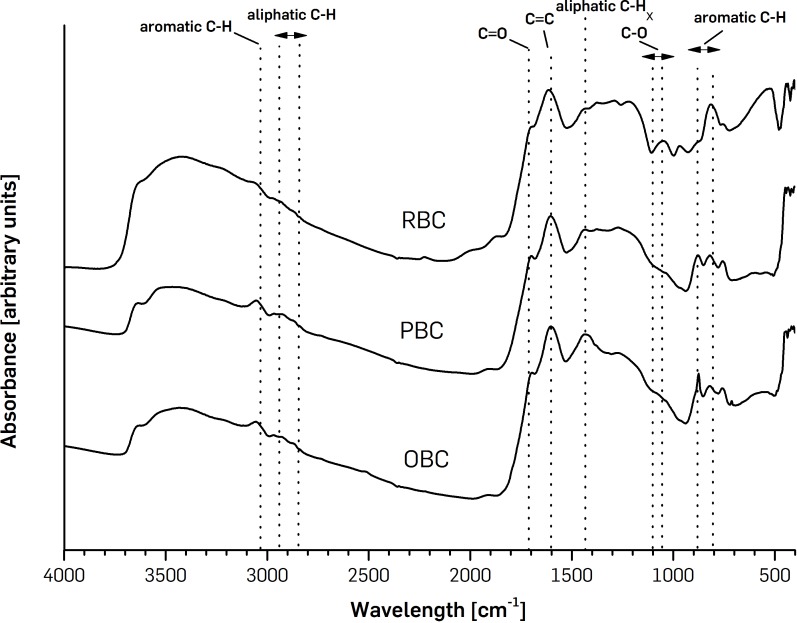
FTIR spectra of pinewoodchips-derived biochar (PBC), olive pruning-derived biochar (OBC) and ricebiochar (RBC) samples.Each curve represents one biochar. Range of representative peaks are indicated.